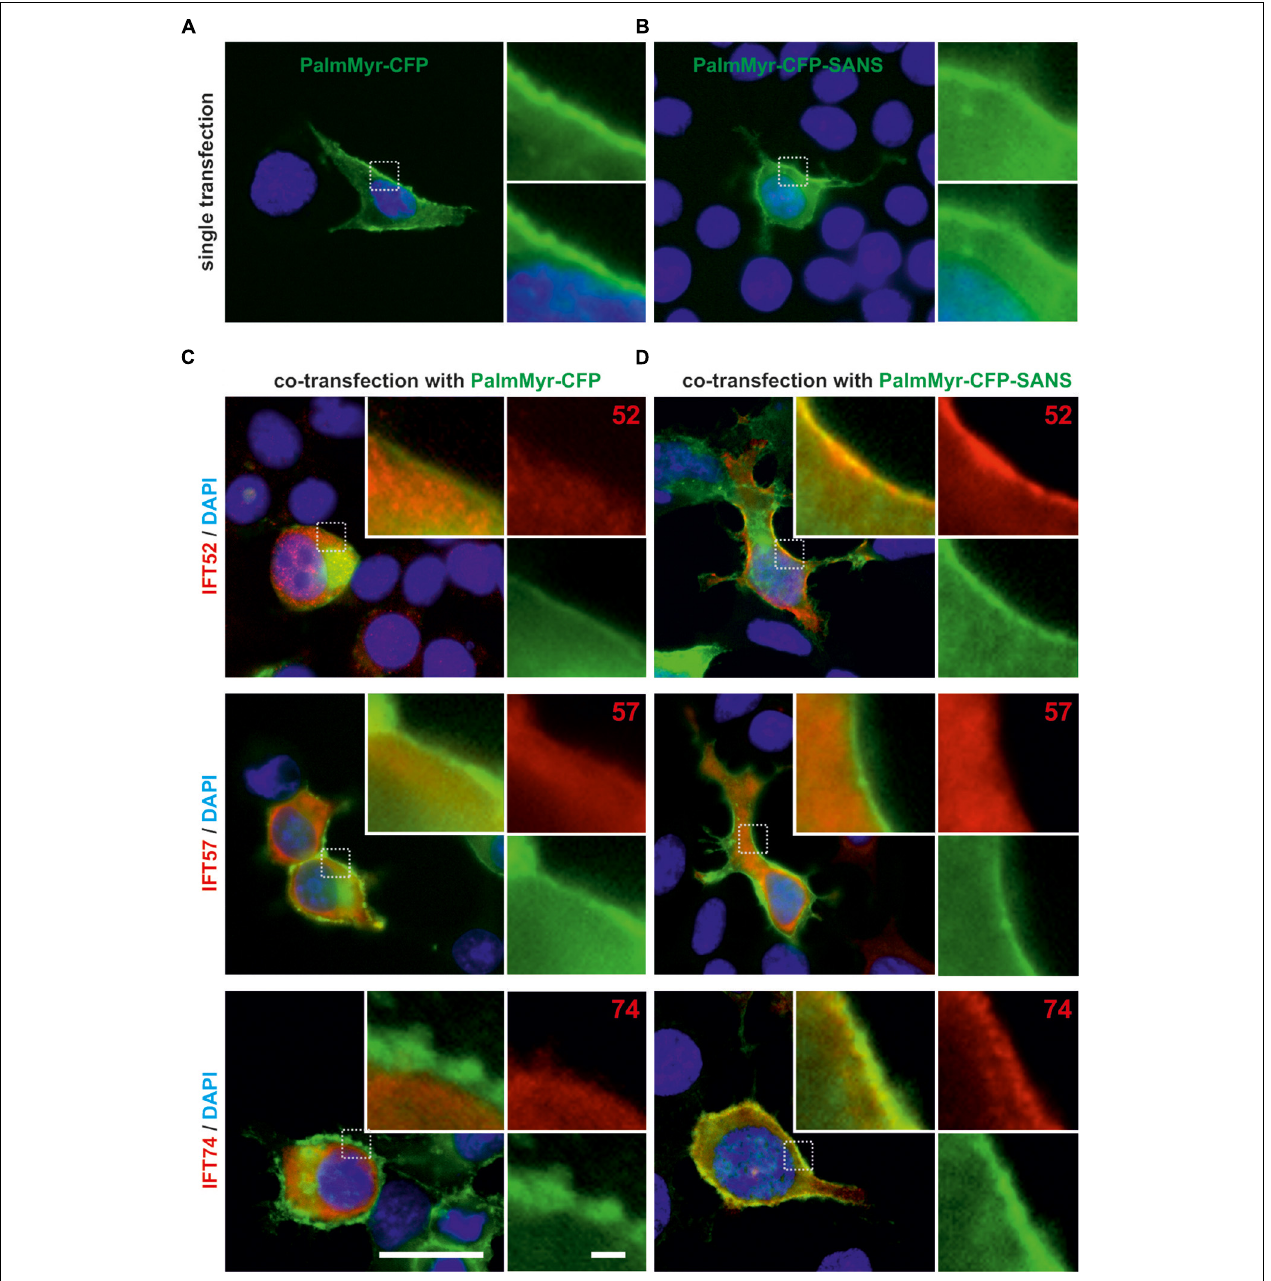
FIGURE 3 | Membrane targeting assay in HEK293T cells revealed in vivo translocation of IFT52 and IFT74 by PalmMyr-CFP-SANS. (A,B) Fluorescence microscopic analysis of HEK293T cells, singly transfected with MyrPalm-CFP or MyrPalm-CFP. MyrPalm-CFP (A) and MyrPalm-CFP-SANS (both in green) (B) , respectively, accumulate at the plasma membrane of single-transfected HEK293T cells. (C,D) Fluorescence microscopic analysis of HEK293T cells, co-transfected with FLAG-tagged IFT20, IFT52, IFT57 or 74, and with MyrPalm-CFP (C) or MyrPalm-CFP-SANS (D) , respectively. In the control, no co-localization of FLAG-IFT proteins with MyrPalm-CFP alone was observed. In contrast, FLAG-IFT52 and FLAG-IFT74 co-localized with MyrPalm-CFP-SANS at the plasma membrane, whereas FLAG-IFT20 and FLAG-IFT57 did not. Blue, DAPI staining of nuclear DNA. Images are representative for co-transfected cells from two independent experiments. Scale bars: 25 µ m; 2.5 µ m in zoomed squares.